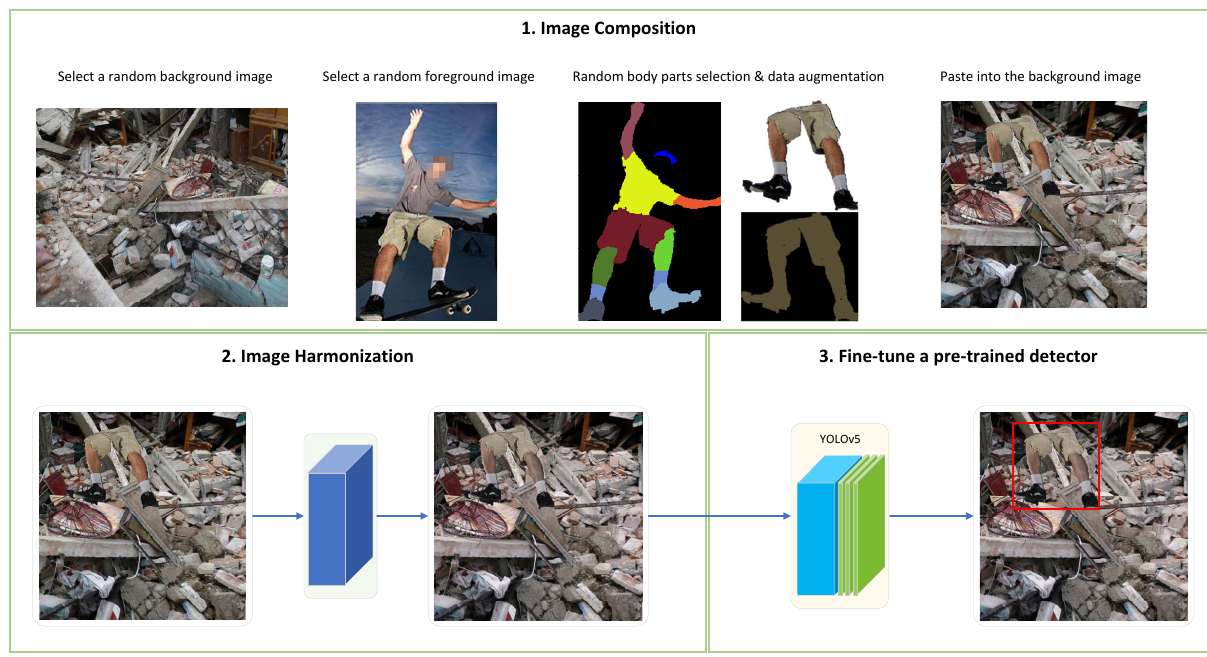
Figure 1. Our approach pipeline includes three steps: (i) image composition, (ii) image harmonization, and (iii) fine-tune a detector. usually contain completely displayed, standing people in